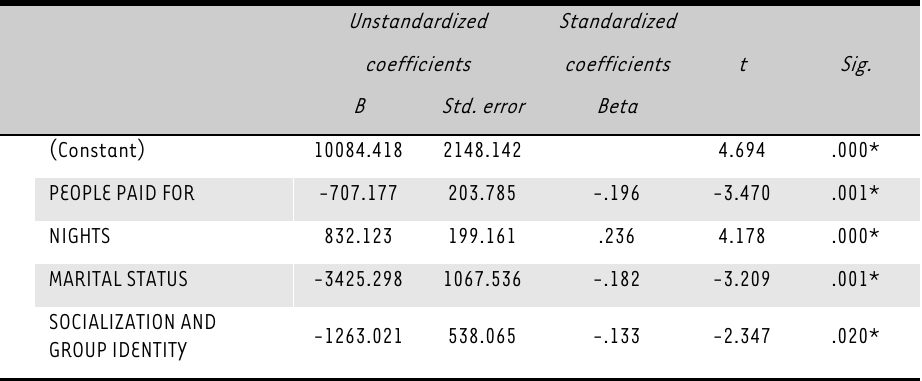
Results from the backward linear regression: determinants of participant spending for the ‘up’ run Unstandardized coefficients